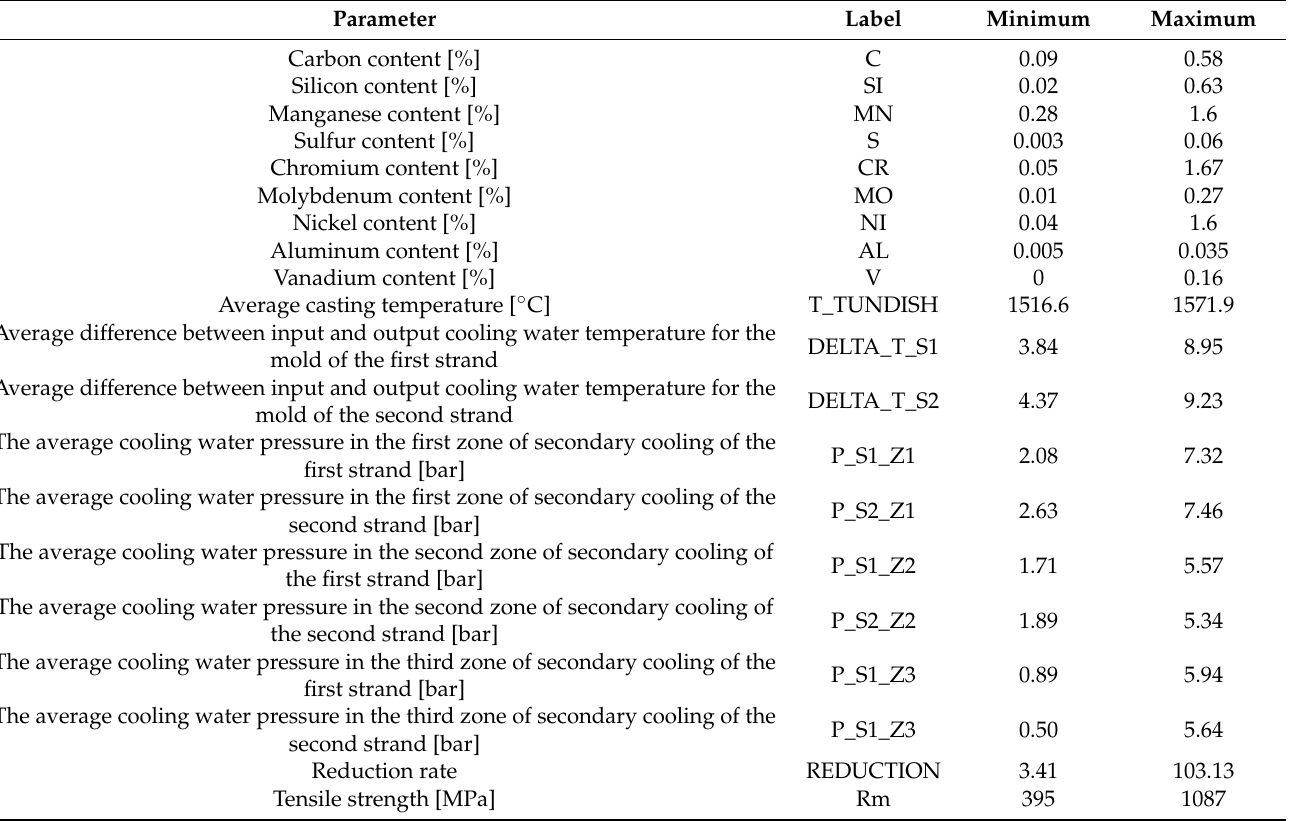
Table 1. Minimal and maximal values of the gathered